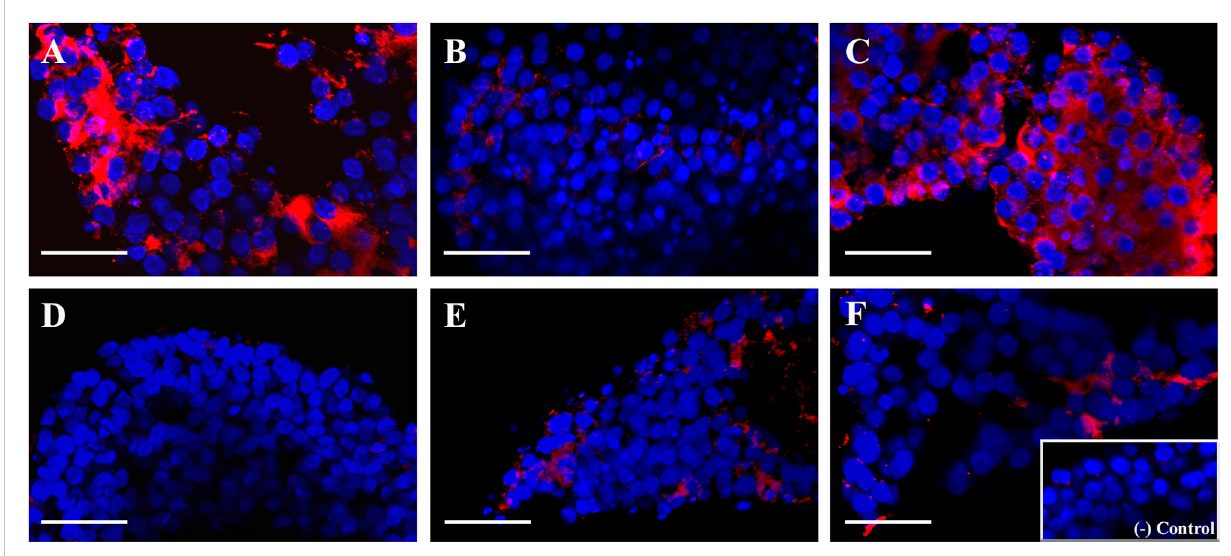
FIGURE 4 MCP1 restored the hyaluronic acid (HA) synthesis inhibited by the EGFR inhibitor. Representative confocal microscopy images (x 40) of feline COCs from C-OE culture under different treatments after HA IF staining. COCs were incubated (24 h) with GNT (A) , GNT + LAPATINIB (B) , GNT + LAPATINIB + MCP1 (C) , LAPATINIB (D) , LAPATINIB + MCP1 (E) , MCP1 (F) . (A – F) Nuclear staining is displayed in blue (Hoechst 33342), and HA in red (Cy3). No staining was observed in the negative control (in the absence of the HA binding protein, Insert). Scale bars 50 μ